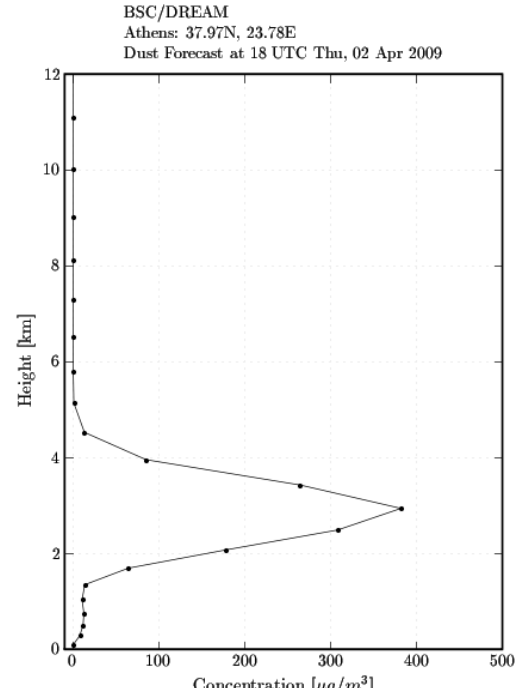
Fig. 4. Forecast of the vertical profile of the dust concentration (inµgm − 3 ) over Athens, Greece for 2 April 2009, at 18:00UT us- ing the BSC-DREAM